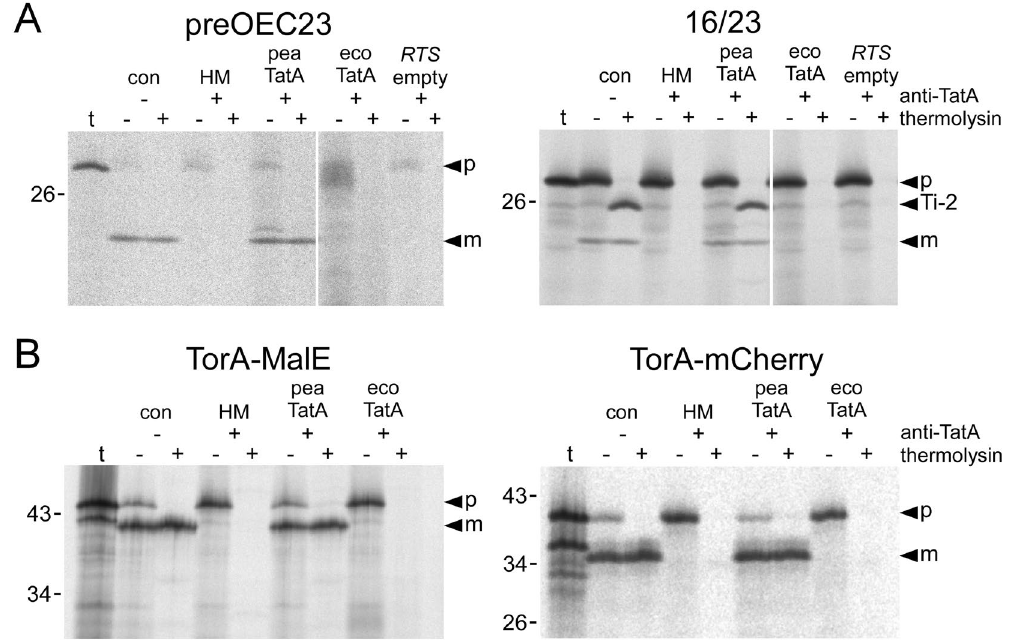
Figure 2. Reconstitution of thylakoidal Tat transport with TatA from pea and E. coli . ( A ) In thylakoido transport of authentic and chimeric plant model Tat substrates in the presence of TatA from pea or E. coli . The authentic precursor of OEC23 ( preOEC 23) and the chimeric precursor protein 16/23 were generated by in vitro transcription of the respective cDNA clones and subsequent in vitro translation in the presence of [ 35 S]-methionine. 5 μ l of each translation assay were incubated with thylakoid vesicles isolated from pea that had been either mock-treated ( con ) or treated with antibodies against TatA ( + anti-TatA ). The latter were subsequently supplemented with either HM buffer only (10 mM Hepes/KOH, pH 8.0; 5 mM MgCl 2 ) ( HM ) or with TatA from pea ( pea TatA ) or E. coli ( eco TatA ), which were obtained by in vitro transcription/translation with the wheat germ rapid translation system ( RTS ). Lanes RTS empty show translation assays containing an empty vector control. After incubation for 15 min in the light at 25 °C, thylakoids were washed once with HM buffer and subsequently incubated with either thermolysin (182 μ g/ml, 30 min on ice, lanes + ) or HM buffer ( lanes − ). From each fraction stoichiometric amounts corresponding to 7.5 μ g of chlorophyll were analysed on 10–17.5% SDS-polyacrylamide gradient gels and detected by phosphorimaging. In lanes t , 1 μ l of the translation assays of the respective Tat substrates was loaded. The bands showing the precursor ( p ) and mature proteins ( m ) are indicated by filled arrowheads . Ti-2 marks the protease-protected fragment indicative of translocation intermediate Ti-2 of the 16/23 chimera in which the passenger protein is fully translocated across the membrane but the Tat transport signal not yet removed 24, 48 . The molecular weights (in kDa) of marker proteins loaded in parallel are indicated on the left of each panel. ( B ) In thylakoido transport of the bacterial model Tat substrates TorA-MalE and